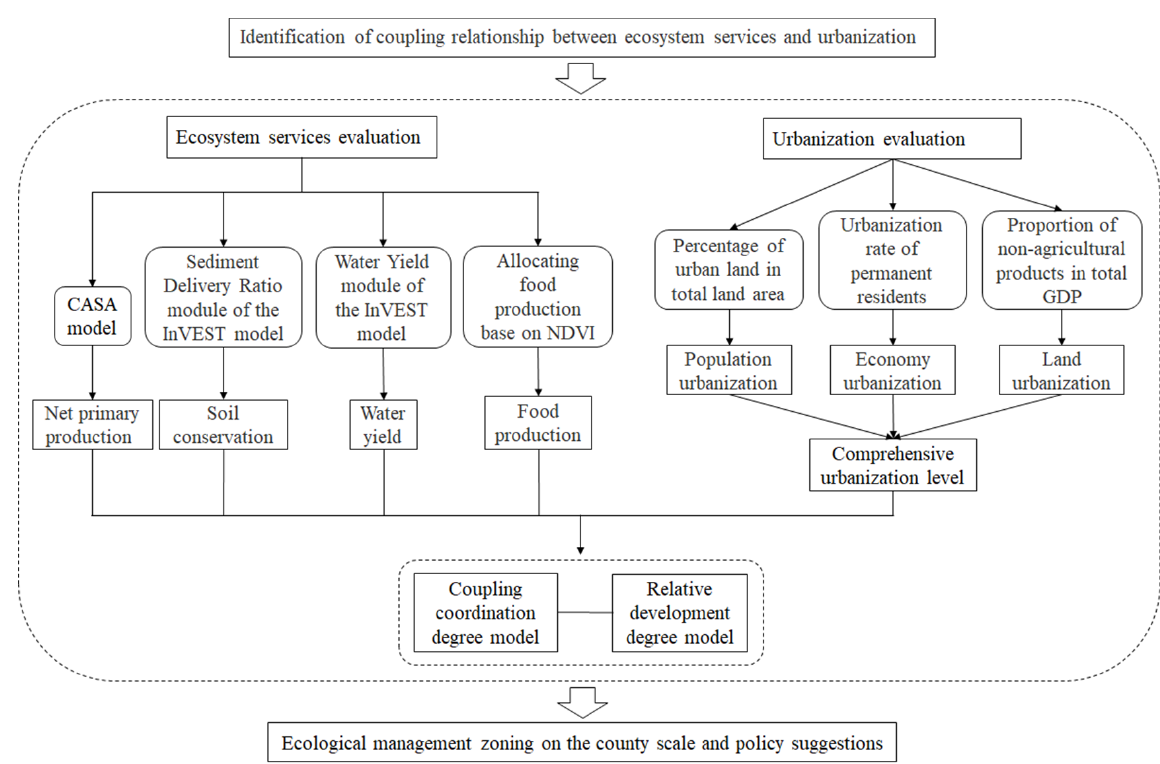
Figure 2. The framework of coupling ecosystem services and urbanization. Table 2. Criteria for selecting ESs in the